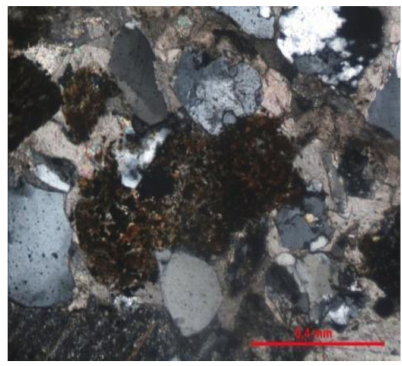
Figure 3. Thin section observations.